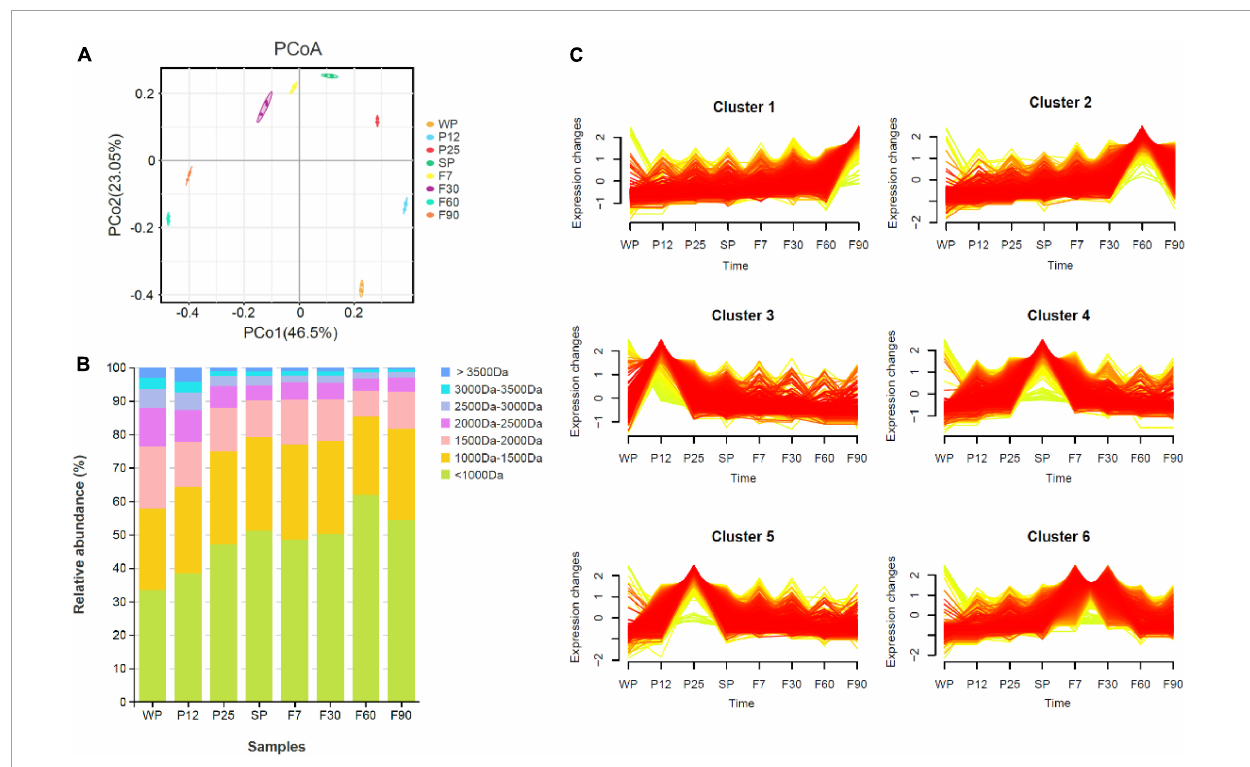
FIGURE2 Peptide analysis during fermentation of sufu. (A) PCA analysis. (B) Molecular weight distribution of total peptides. (C) Trend analysis of differentially expressed peptides.